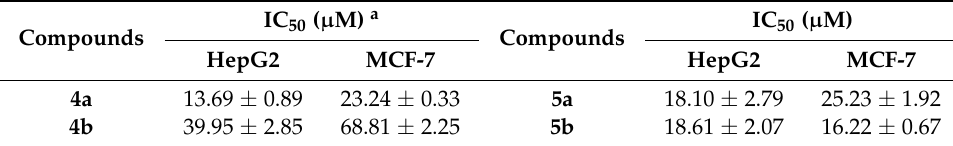
Table 2. Anti-proliferative activities of compounds 4a , 4b , 5a and 5b .